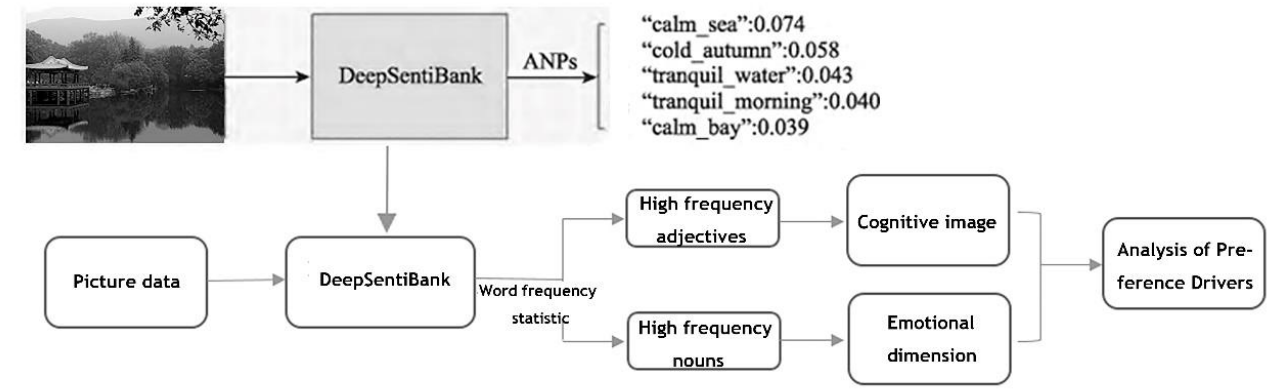
Figure 2. Schematic diagram of DeepSentiBank picture-based destination perception study.